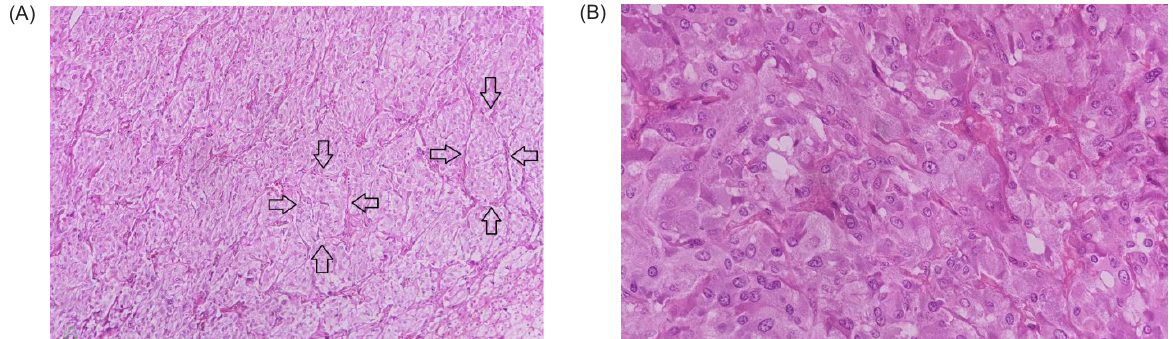
Figure 3: Microscopic section of adrenal mass shows: (A) Zellballen nested pattern (arrow) outlined with sustentacular cells (Hematoxylin and Eosin, 100×). (B) Polygonal tumoral cells with abundant granular cytoplasm and prominent nucleoli (Hematoxylin and Eosin,